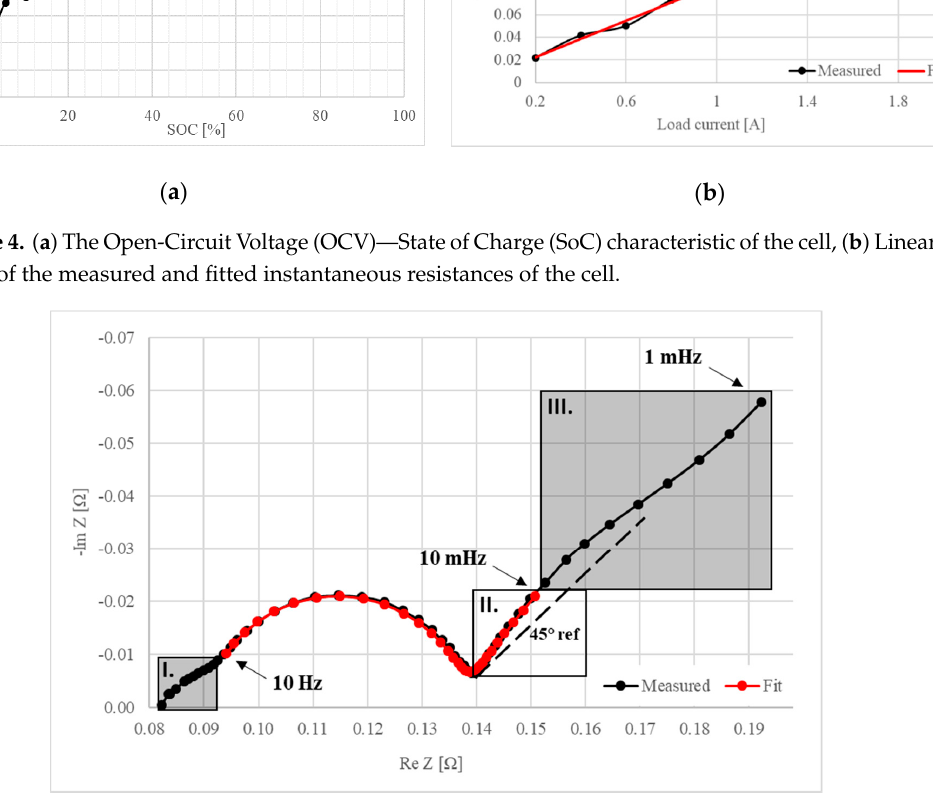
Figure 5. Nyquist plot of a Samsung ICR18650-26F 2600mAh cell at 100% SoC and room temperature. Parameter estimation is based on the frequency range of 10 mHz to 10 Hz. Part I.—SEI can be observed here, however, it has a negligible effect on liquid-phase diffusion in part II. (neglected zone); Part II.—diffusion dominates in the electrolyte; Part III.—diffusion dominates in the solid electrodes (neglected zone). The generalized Warburg element shows a better fit on non-ideal diffusion than the standard Warburg element, which is only suitable for a phase angle of 45°.